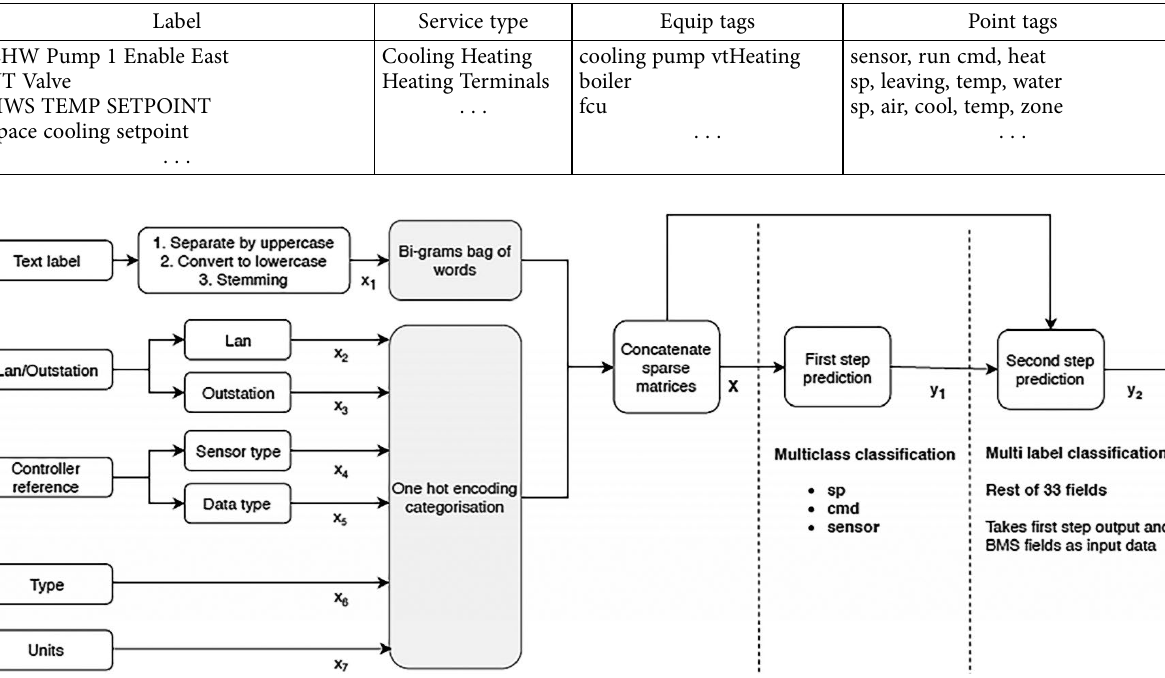
Figure 4. BMS label classification process for pre-processing data and predicting